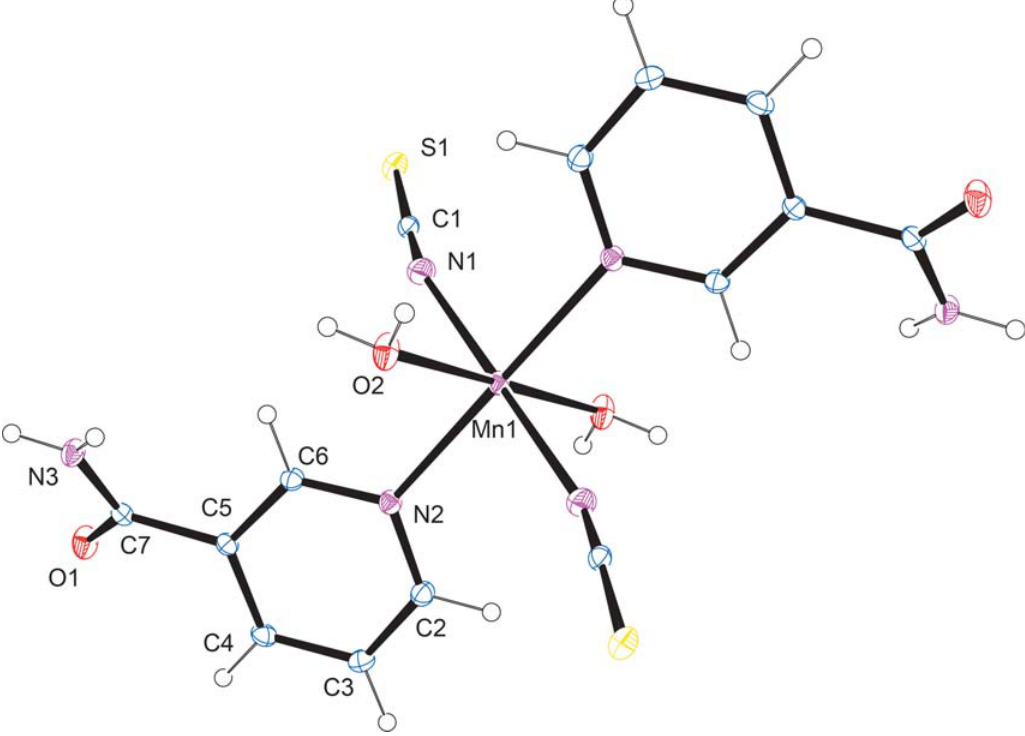
Figure 1. An ORTEP representation of coordination molecules in 1 with labels for atoms in asymmetric unit. Thermal ellipsoids are drawn at 30% probability level. Hydrogen atoms are represented as small spheres of arbitrary